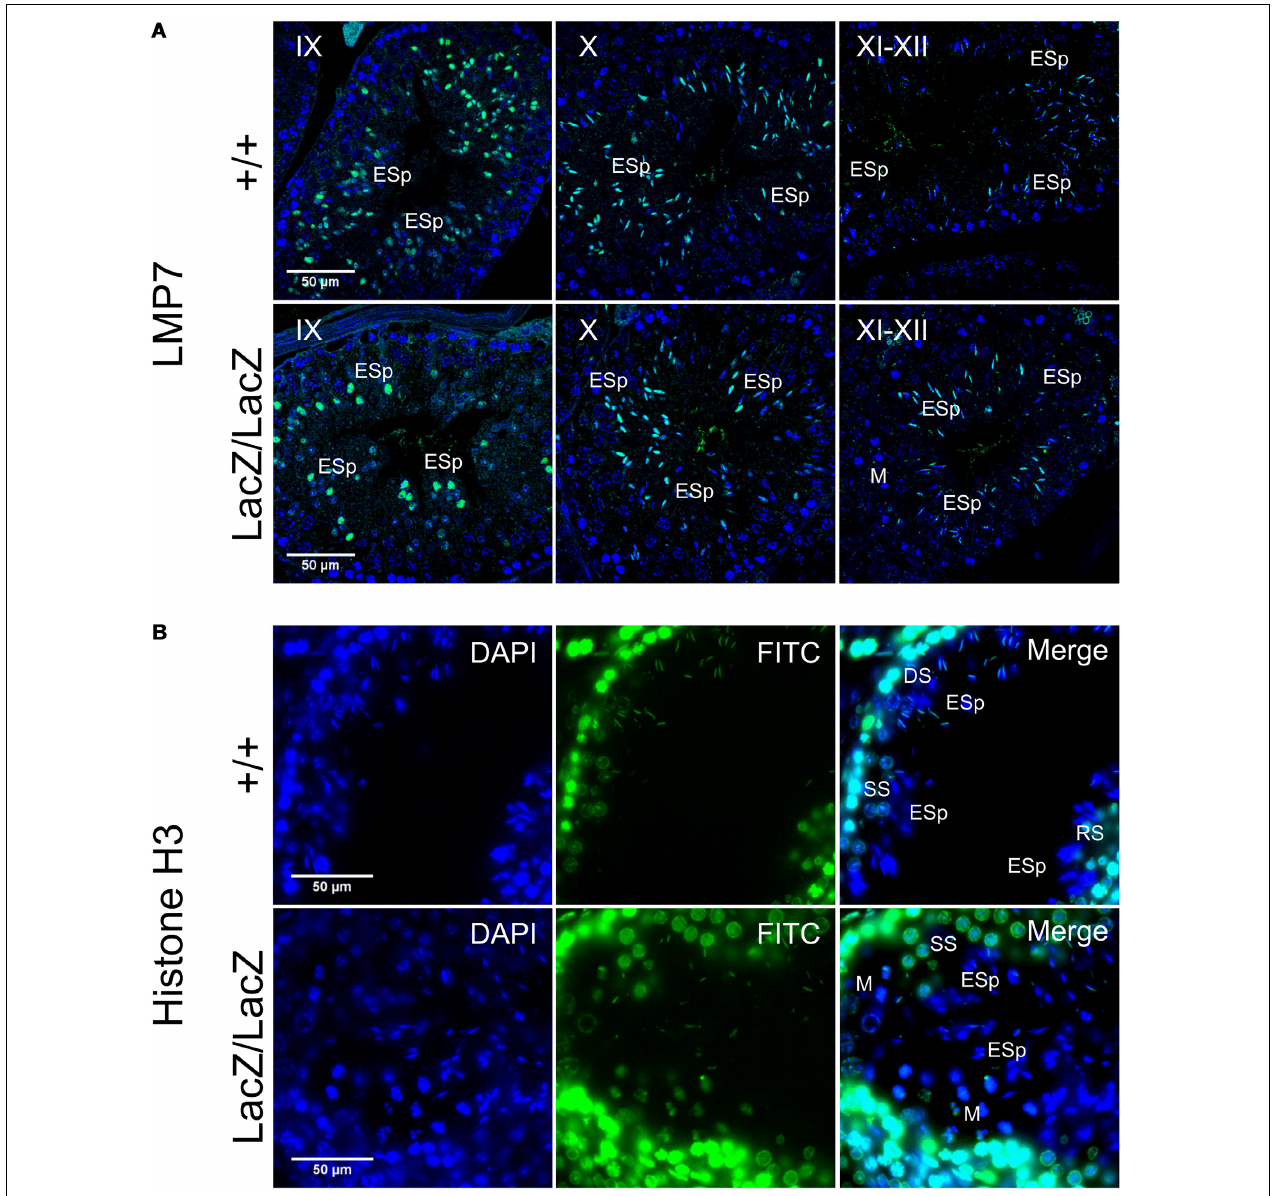
FIGURE 5 | Immunochemical staining of LMP7 and histone H3 in Fbxo7LacZ/LacZ testis sections. (A) Immunochemical staining of LMP7 (FITC, green) in wild type and Fbxo7LacZ/LacZ testes with DAPI (blue) nuclear counterstain. Roman numerals indicate tubule stage. In both genotypes, nuclear LMP7 expression is first seen in early ES at mid-stage IX as the nuclei begin to elongate. This nuclear expression is highest at stage X, and then is lost during stage XI-XII as nuclei complete elongation. (B) Immunochemical staining of histone H3 (FITC, green) in wild type and Fbxo7LacZ/LacZ testes with DAPI (blue) nuclear counterstain. The wild type tubule shown is in transition between stages, with early stage XII (DS next to ESp) at upper left, mid stage XII (SS next to ESp) at lower left and stage XII/I border (M and RS next to ESp) at lower right. Nuclear H3 signal in ESp is still present at early stage XII, is restricted to the posterior of the nucleus in mid stage XII, and entirely lost by stage I. The Fbxo7LacZ/LacZ tubule shown is in mid stage XII, and the H3 signal in the ESp is absent or restricted to the posterior extremity of the nucleus, confirming the kinetics and spatial pattern of H3 removal are indistinguishable between genotypes. Key: DS = diplotene spermatocytes, SS =